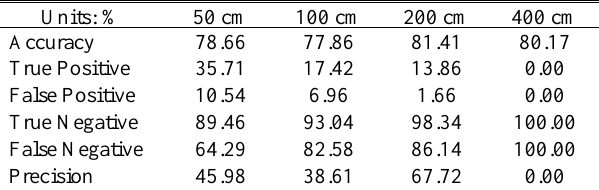
Table 10. Accuracy statistics of the classification